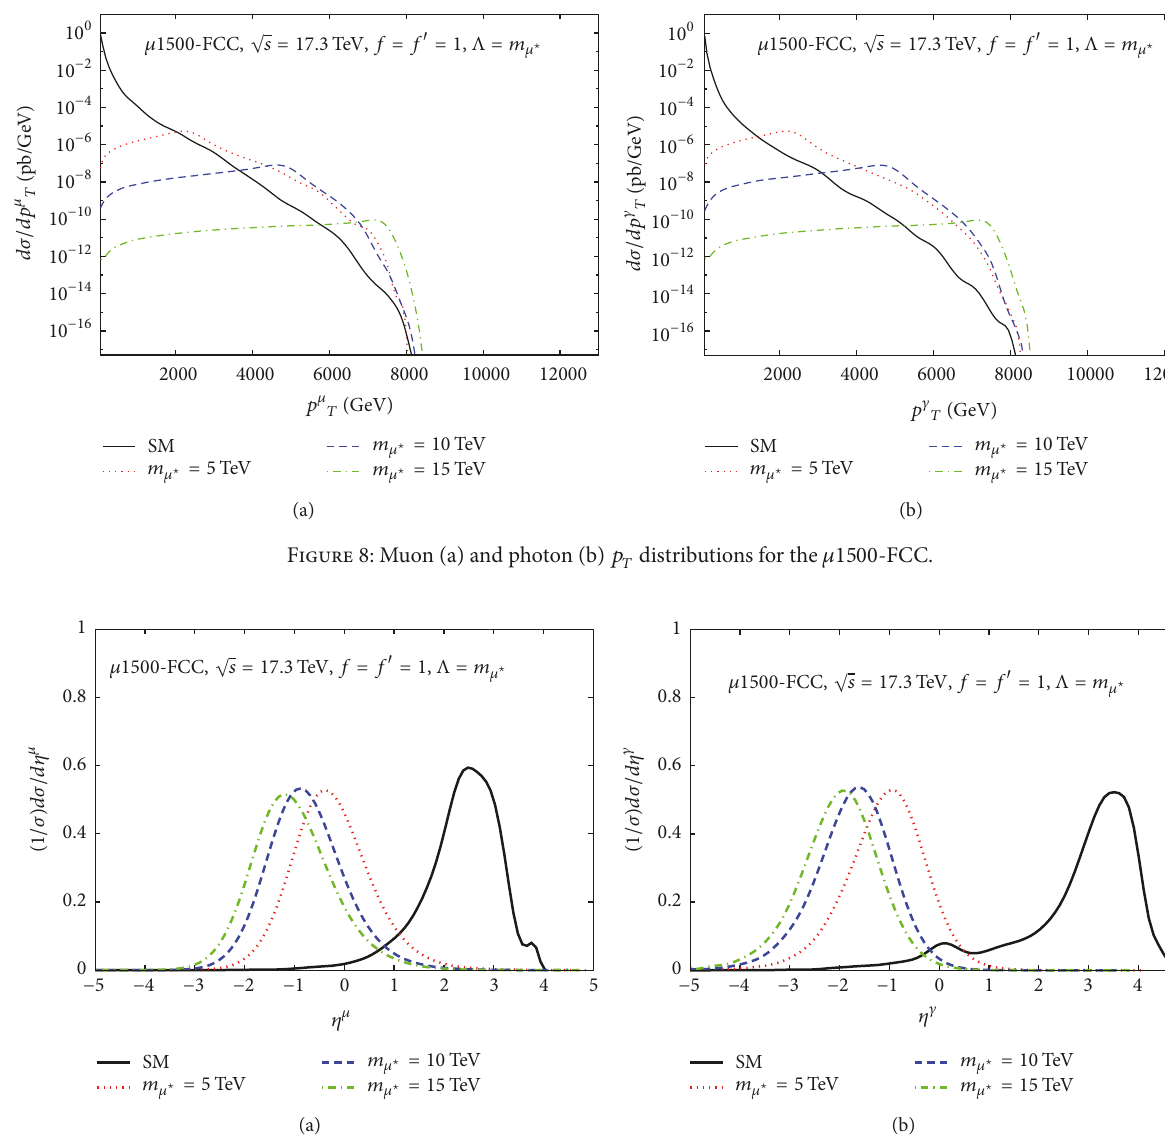
Figure 9: Muon (a) and photon (b) normalized 𝜂 distributions for the 𝜇750 -FCC 𝜇1500 -FCC.